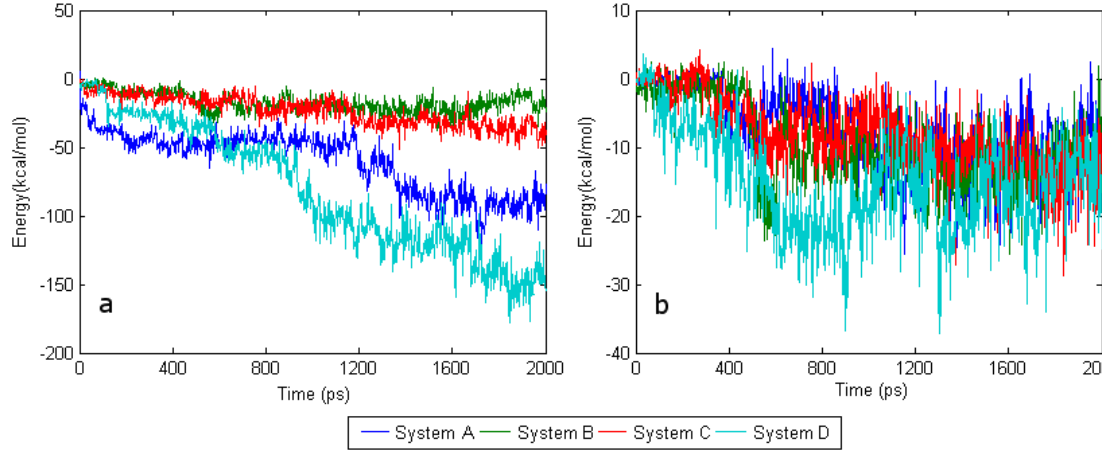
Figure 4. Trends for the interaction energy between FAD/isoalloxazine and water. (a) Interaction energy of FAD with water, (b) of isoalloxazine with